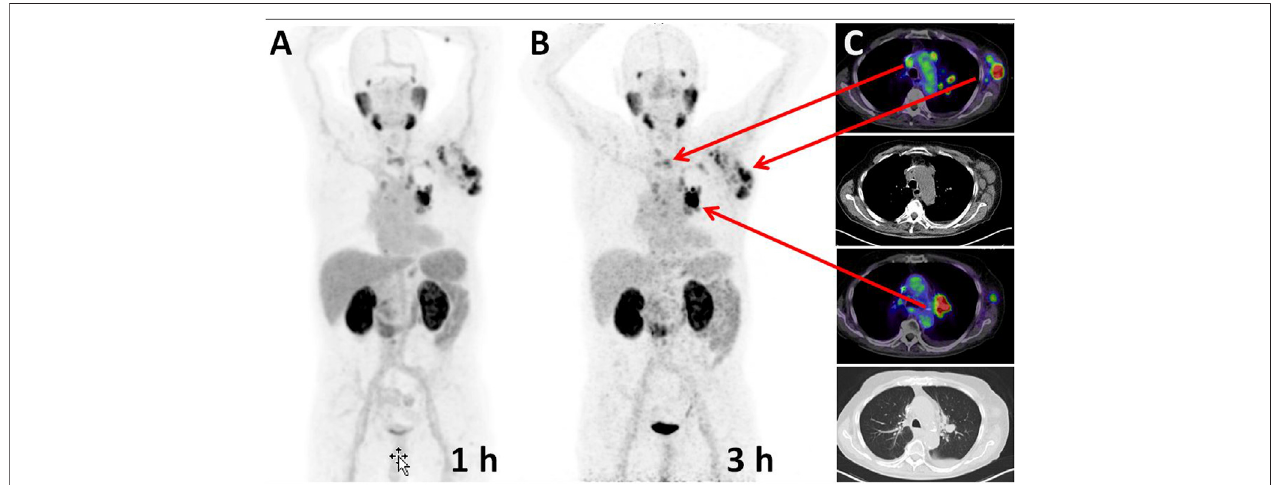
FIGURE 7 | Maximum intensity projections of a PSMA-PET of a prostate cancer patient performed 1 h (A) and 3 h (B) post injection of 339 MBq/20 nmol 68 Ga- CA028. (C) Cross-sectionalslicesdemonstrateaxillaryandhilarlymphnodemetastases(redarrows),alsodelineableonthecorrelatedCTwhichservesasastandardof reference.